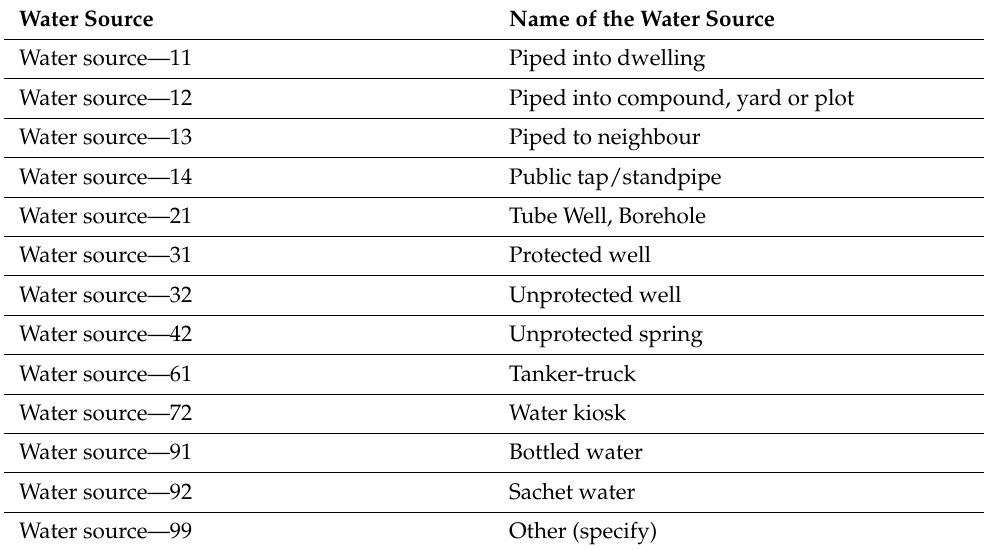
Table A3. Description of the category